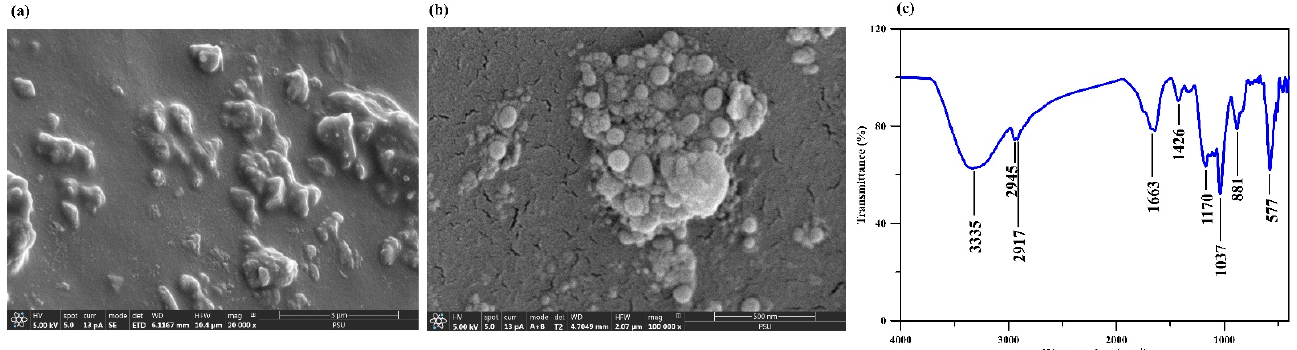
Figure 3. SEM images of the hydrogel used for phosphate detection at ( a ) 20,000× and ( b ) 100,000× and ( c ) its FTIR